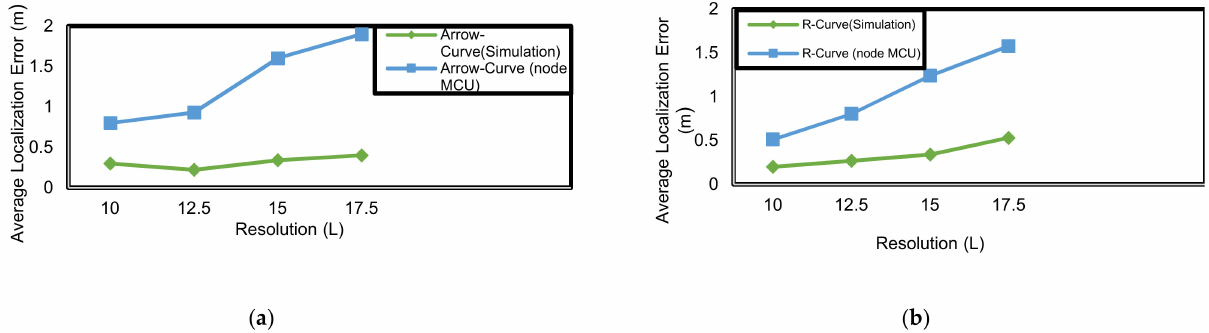
Figure 26. Average localization error (m) corresponding to resolution (L) in both simulation and real environment: ( a ) Arrow-Curve path model; ( b ) R-Curve path